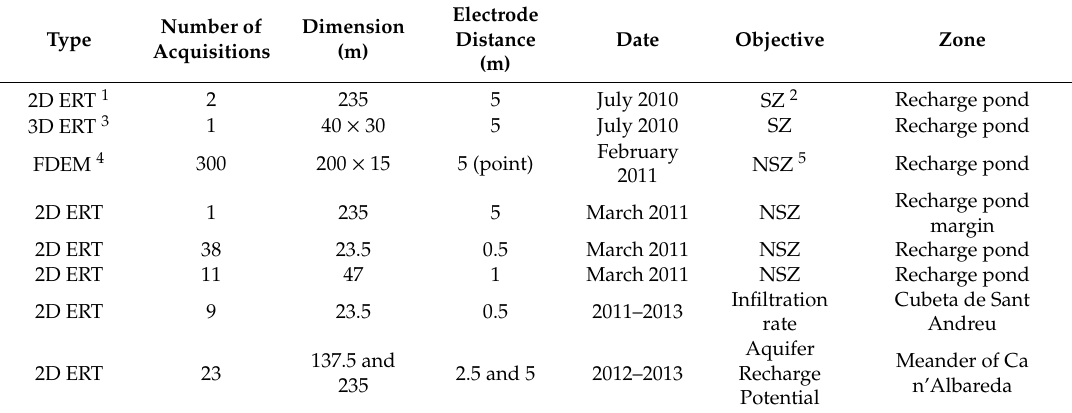
Table 1. Geophysical acquisition campaigns for assessing hydraulic properties in the Cubeta de Sant Andreu